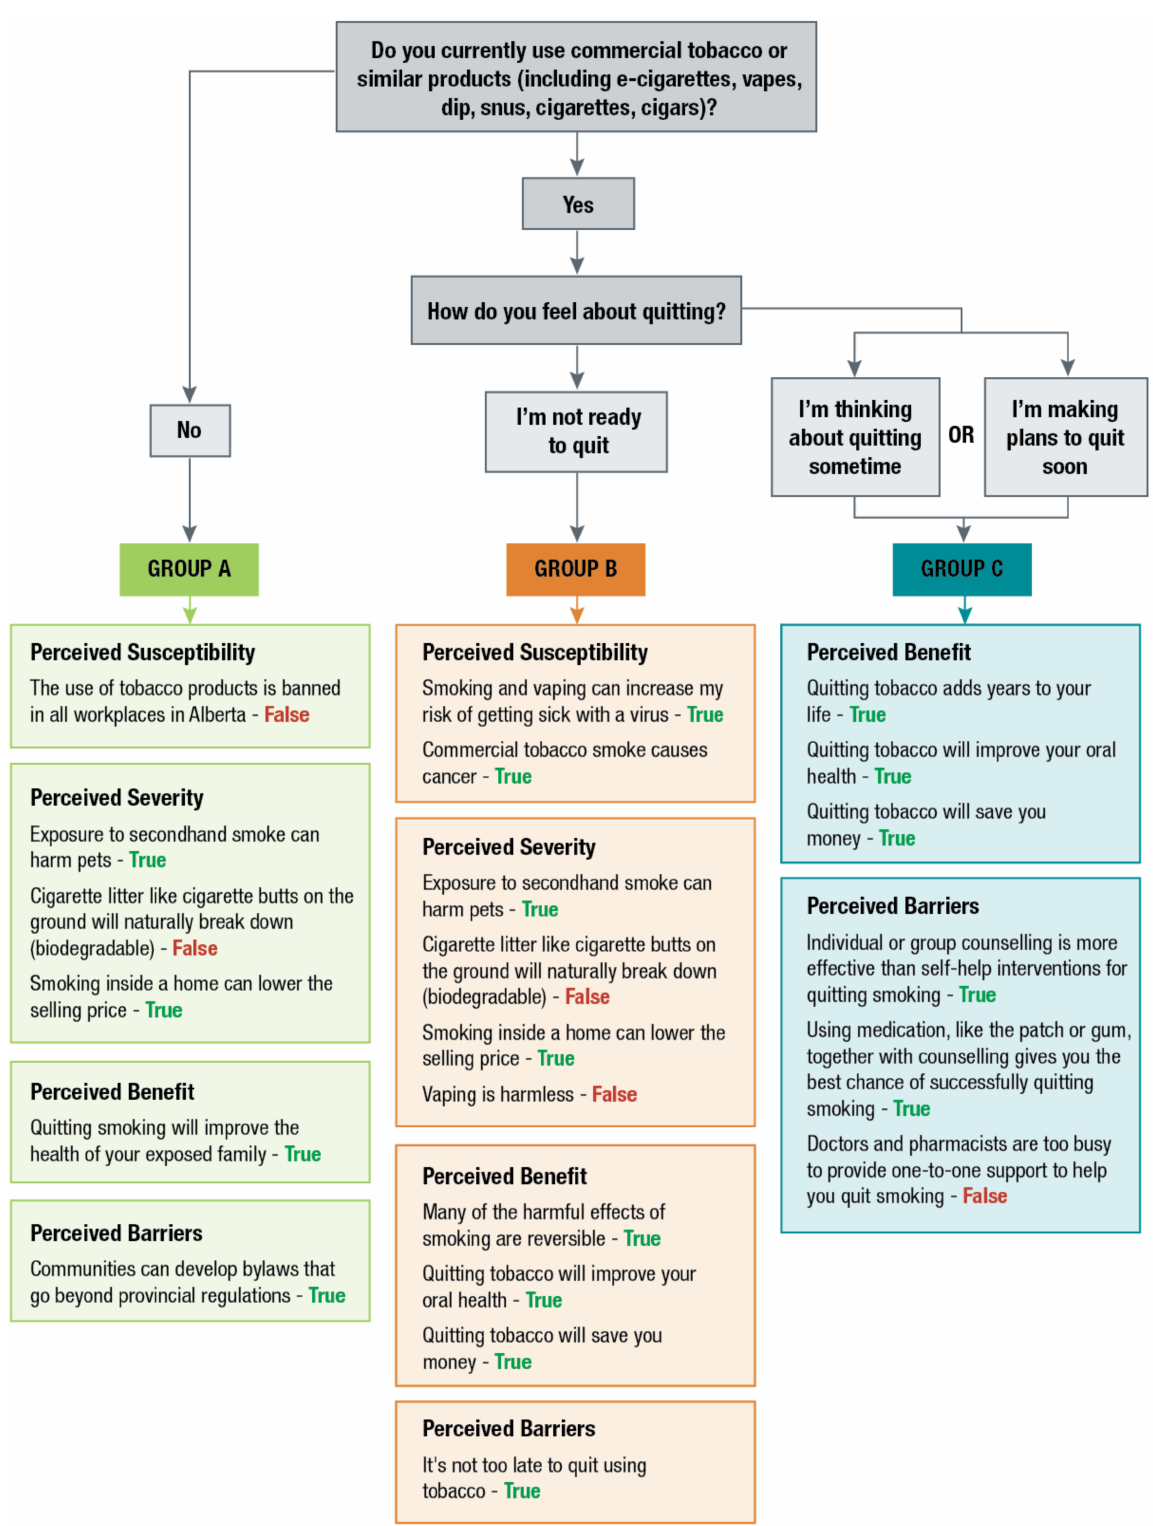
Figure 1. Fact or Fiction Tobacco Conceptual